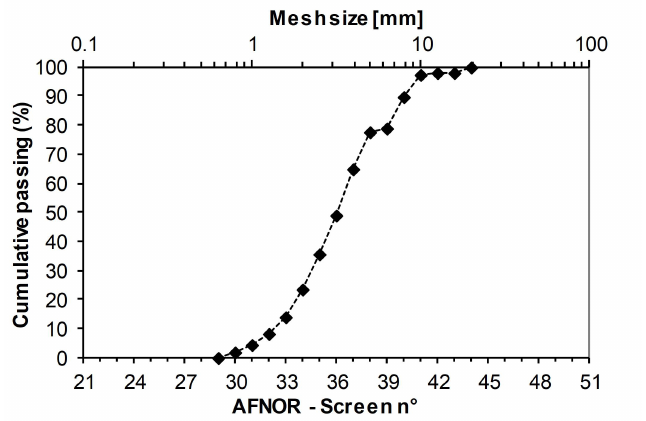
Figure 1. Particle size distribution of hemp shiv (Chanvribat from